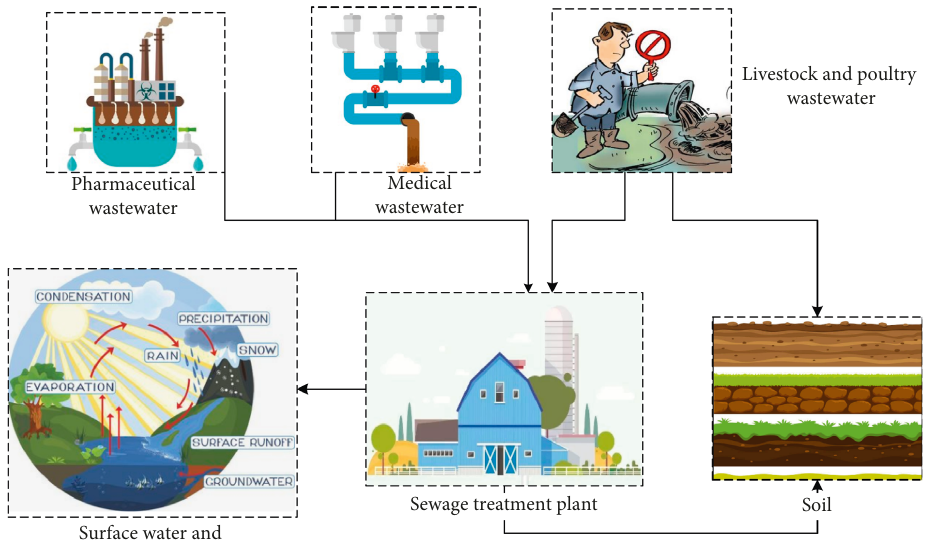
Figure 1: Pathways of antibiotic transfer.